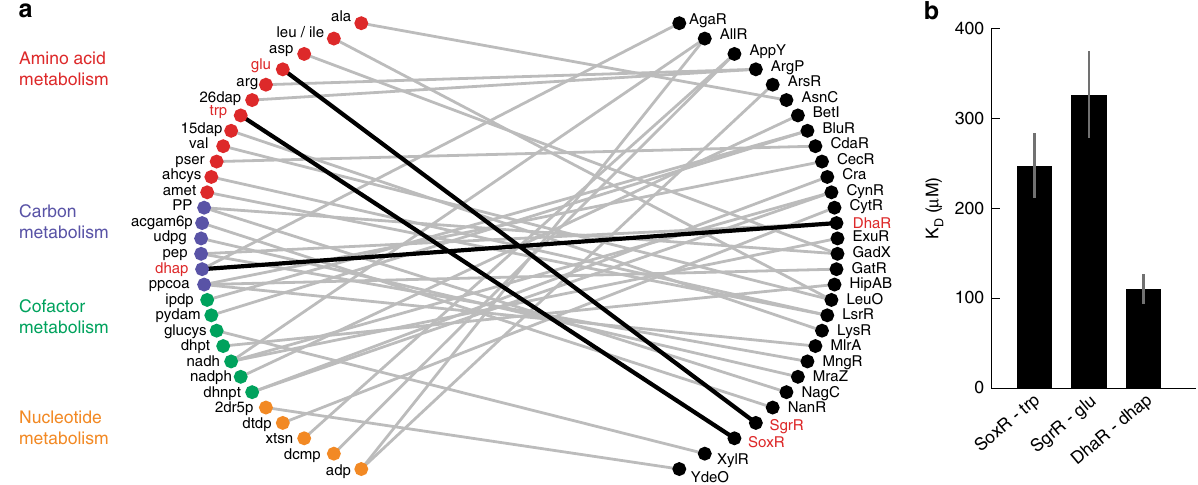
Fig. 5 Identi fi cation and validation of new metabolite-transcription factor interactions. a Network of potentially new interactions between transcription factors and metabolites. Shown are 30 transcription factors that correlated with one or maximal two metabolites (only metabolites that ful fi ll the distance criterion). Metabolites are colored according to the subsystems of amino acid metabolism (red), carbon metabolism (purple), cofactor metabolism (green) or nucleotide metabolism (yellow). Connections in bold black highlight new interactions that are validated in vitro. b In vitro measured K D values of the new interactions indicated in bold in ( a ). Binding was measured with His-tag puri fi ed SoxR, SgrR, and DhaR using micro scale thermophoresis (MST). Error bars show the 95% con fi dence intervals of K D estimates, which are based on fi tting n = 9 MST assays (proteins puri fi ed three times, each measured in three MST assays). MST data are shown Supplementary Fig. 9. ala alanine, leu/ile leucine/isoleucine, asp aspartate, glu glutamate, arg arginine,